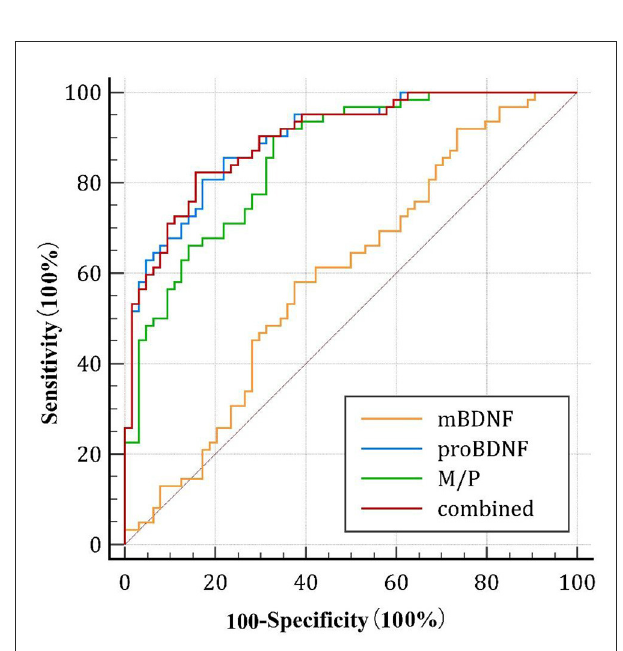
FIGURE3 Diagnostic value of the serum mBDNF, proBDNF, and M/P levels. ROC, receiver operating characteristic; mBDNF, mature brain-derived neurotrophic factor; proBDNF, the precursor of brain-derived neurotrophic factor; M/P, the ratio of mBDNF levels to proBDNF